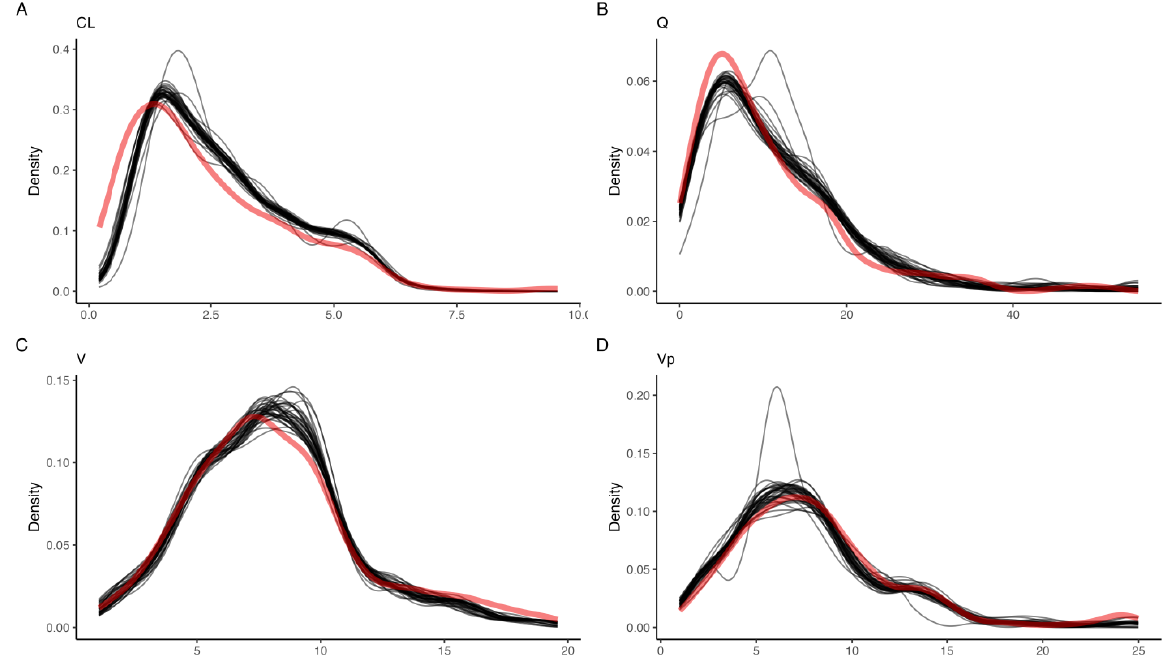
Figure 6. Kernel density estimates for all empirical deviations in time (black), compared to the observed posterior (red) for ( A ) clearance from the central compartment (CL), ( B ) inter-compartmental clearance (Q), ( C ) central volume (V), and ( D ) peripheral volume (Vp).